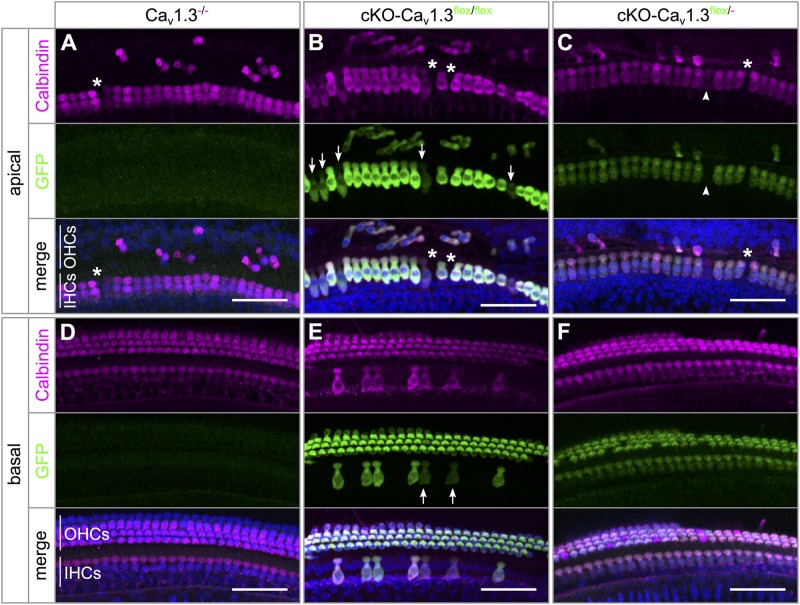
Pattern of eGFP immunolabeling and degree of basal-turn degeneration differ between IHCs of cKO-Cav1.3flex/flex and cKO-Cav1.3flex/- mice. Maximum intensity projections (MIP) of confocal stacks of whole-mount organs of Corti from 4 to 5 week-old mice. Stretches of ∼25 IHCs and adjacent OHCs from apical (A–C) and basal (D–F) cochlear turns of a Cav1.3-/-
(A,D), a cKO-Cav1.3flex/flex
(B,E) and a cKO-Cav1.3flex/- mouse (C,F) were co-immunolabeled for the hair cell marker calbindin (magenta, top) and for GFP (green, middle). Merged colors are shown below with DAPI-stained nuclei (blue). (A–C) GFP labeling was irregular among IHCs of a cKO-Cav1.3flex/flex mouse (arrows: IHCs with weak GFP labeling), but regular among IHCs of a cKO-Cav1.3flex/- mouse (arrowhead: IHC without GFP signal). Independently of the genotype, Cav1.3-deficiency in the apical cochlear turn resulted in degeneration of few IHCs [asterisks in panels (A–C)], whereas the majority of OHCs were degenerated. (D) No degeneration of IHCs or OHCs in the basal cochlear turn of a Cav1.3-/- mouse. (E) In a cKO-Cav1.3flex/flex mouse, the majority of IHCs was degenerated, with the remaining IHCs showing heterogeneous GFP labeling (arrows: weak GFP signal). (F) Uniform GFP labeling in IHCs and lack of hair cell degeneration in the basal turn of a cKO-Cav1.3flex/- mouse. Scale bar: 50 μm.